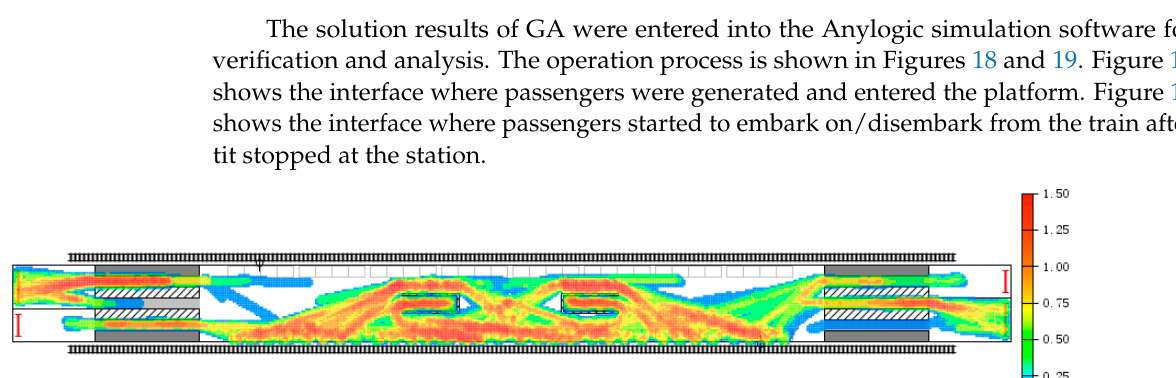
Figure 17. The speed and operating condition conversion points among the four stations.